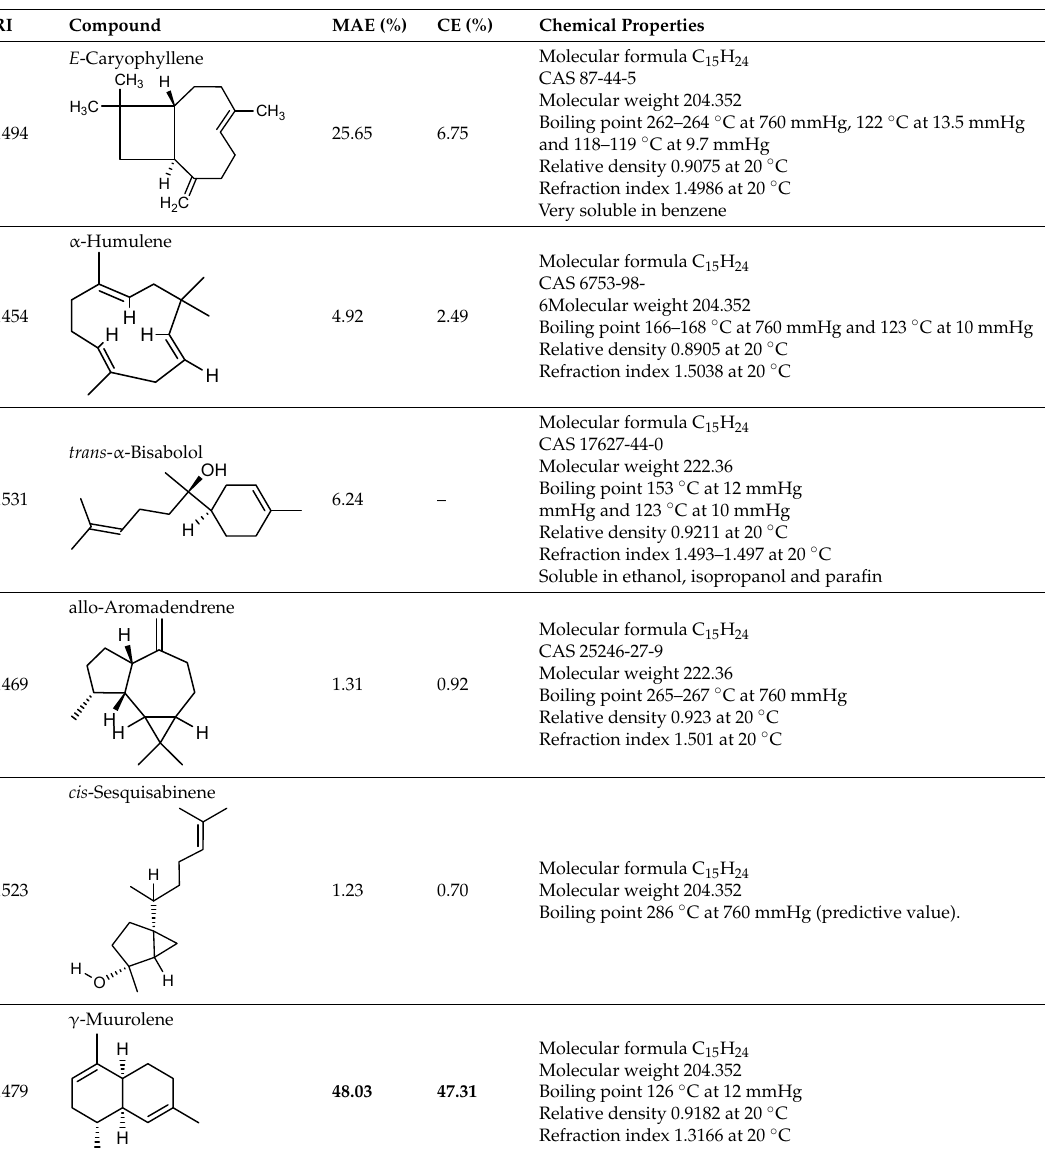
Molecular formula C 15 H 24 Molecular weight 204.352 Boiling point 286 °C at 760 mmHg (predictive value).